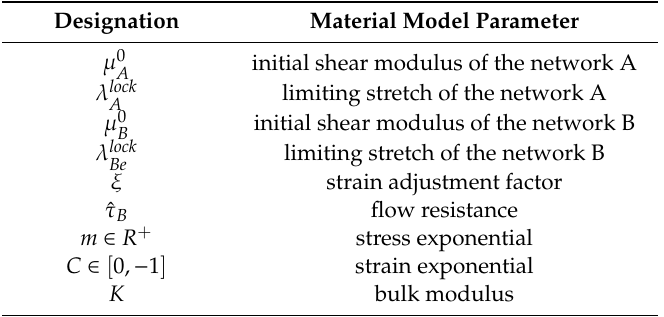
Table 1. Material constants of the Bergström–Boyce constitutive